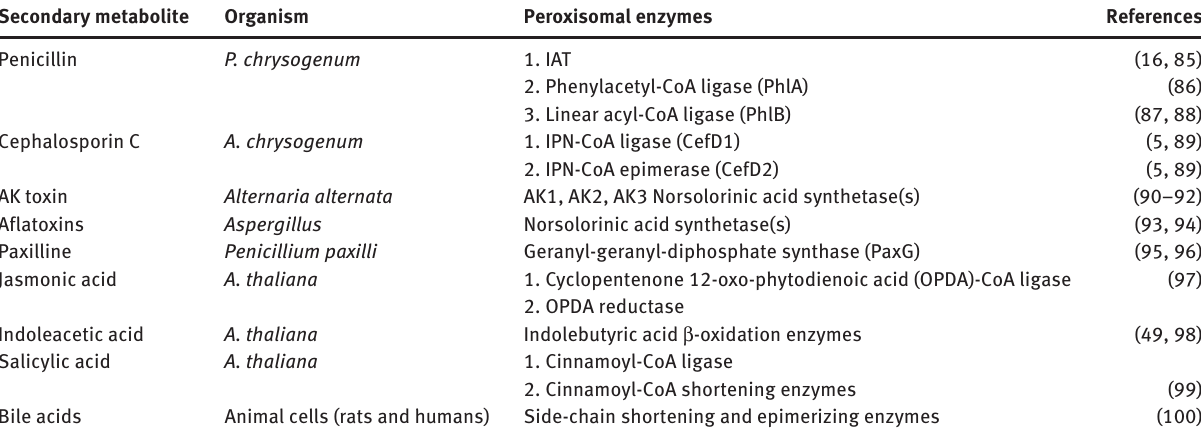
Table 1 Enzymes for secondary metabolite biosynthesis located in peroxisomes fungi, plants, and animal cells. Secondary